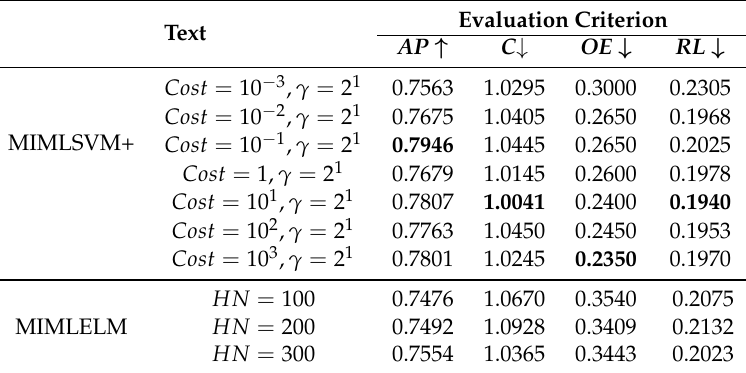
Table 3. The effectiveness comparison on the Text dataset.